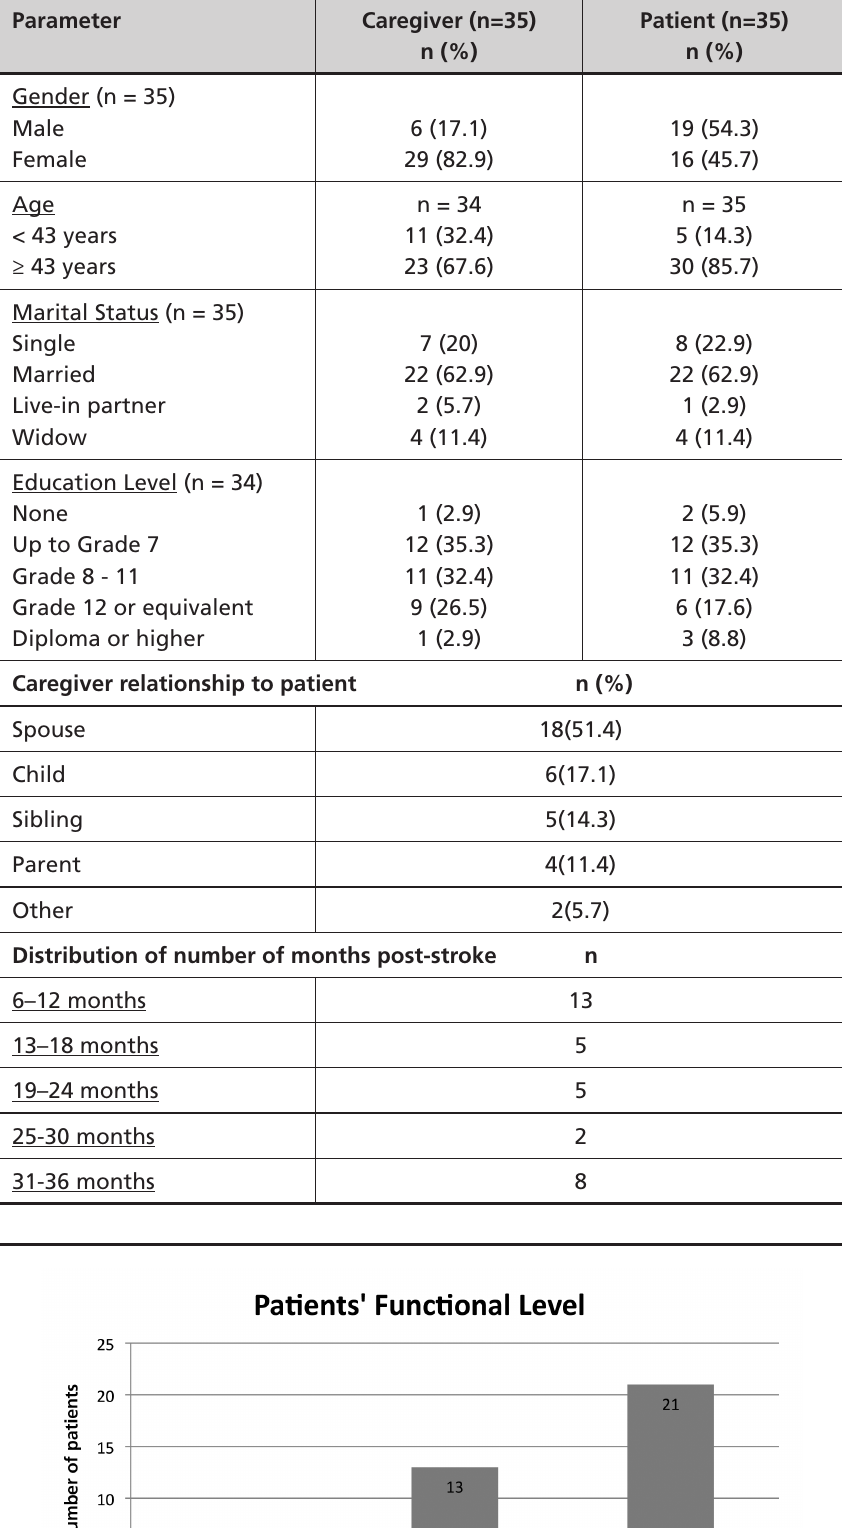
Table 1: Distribution of the caregiver and patient demographic information Parameter